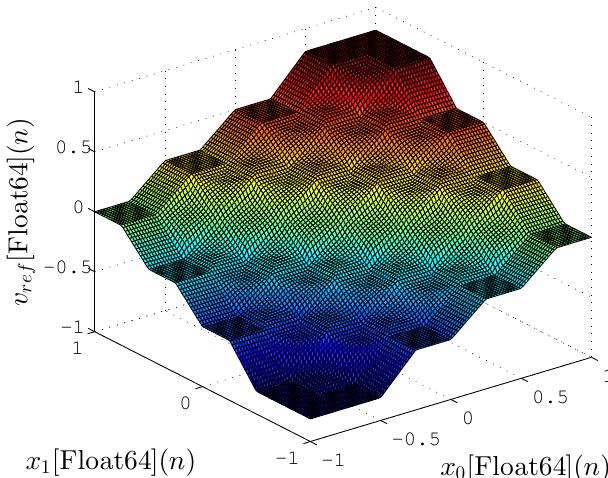
Figure 19. Mapping between input and ouput from TS-FIMM generated by Matlab Fuzzy Logic Toolbox using a double format.